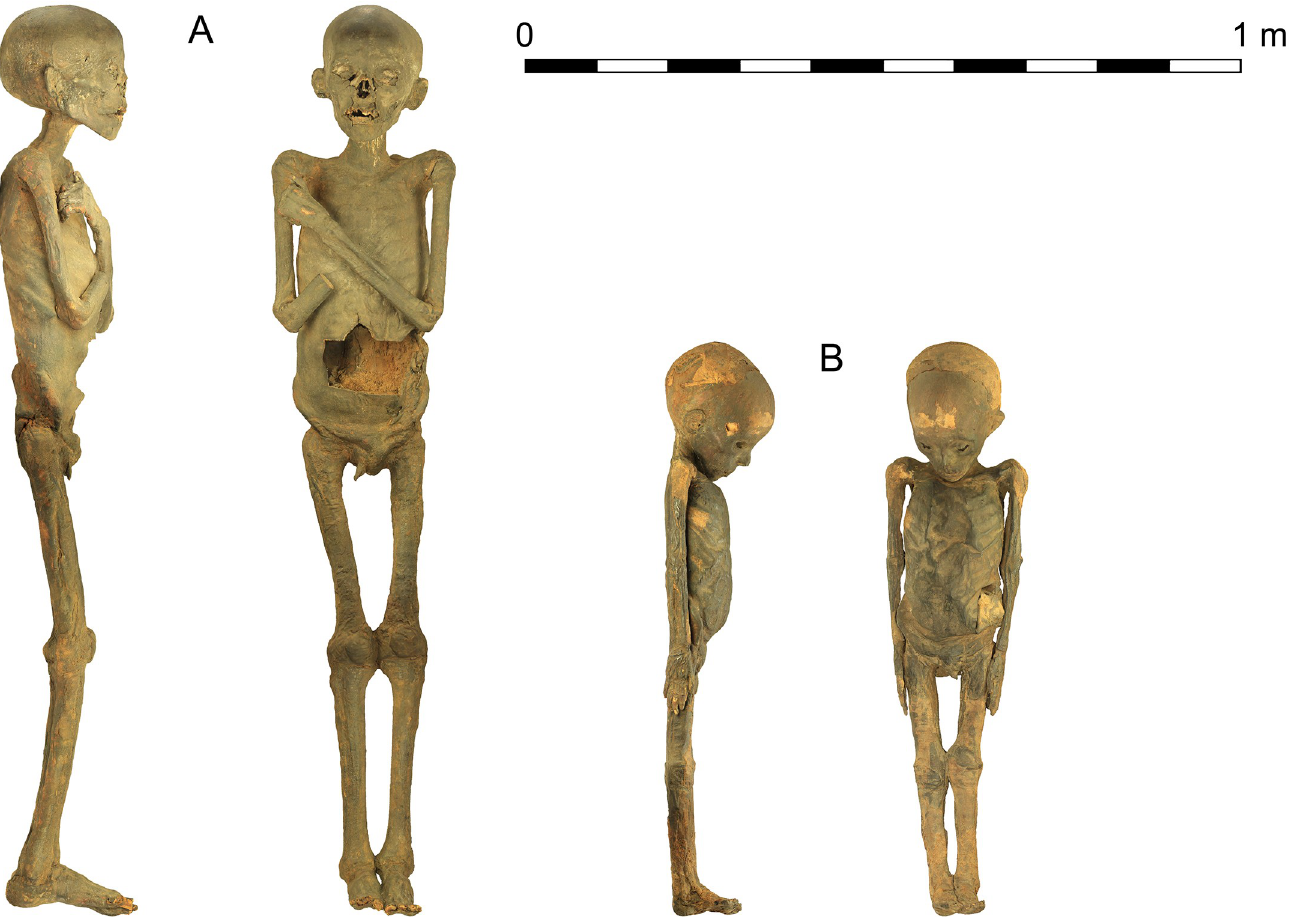
Fig 1. The two human mummies from the collections of the University of Tartu Art Museum. A—older mummy (OM; KMM A 64); B—younger mummy (YM; KMM A 63).